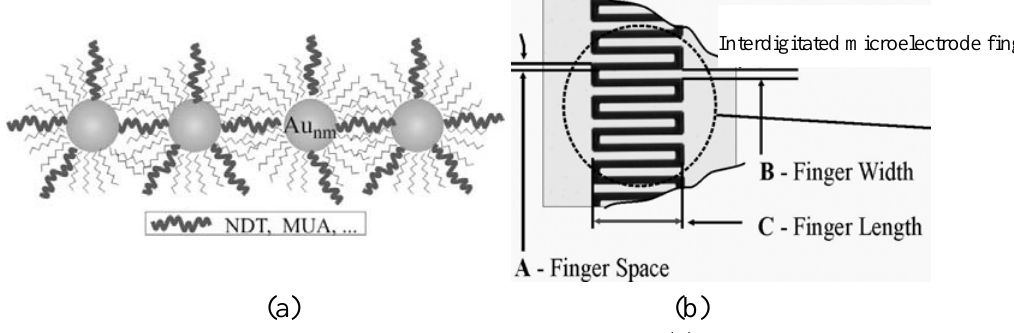
Figure 1. Illustration of the nanostructured thin film assembly (a), and the design of the finger width, space and length of IME (b).